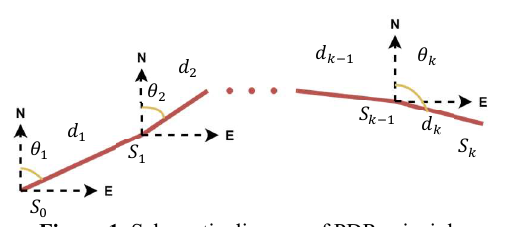
Figure 1 . Schematic diagram of PDR principle